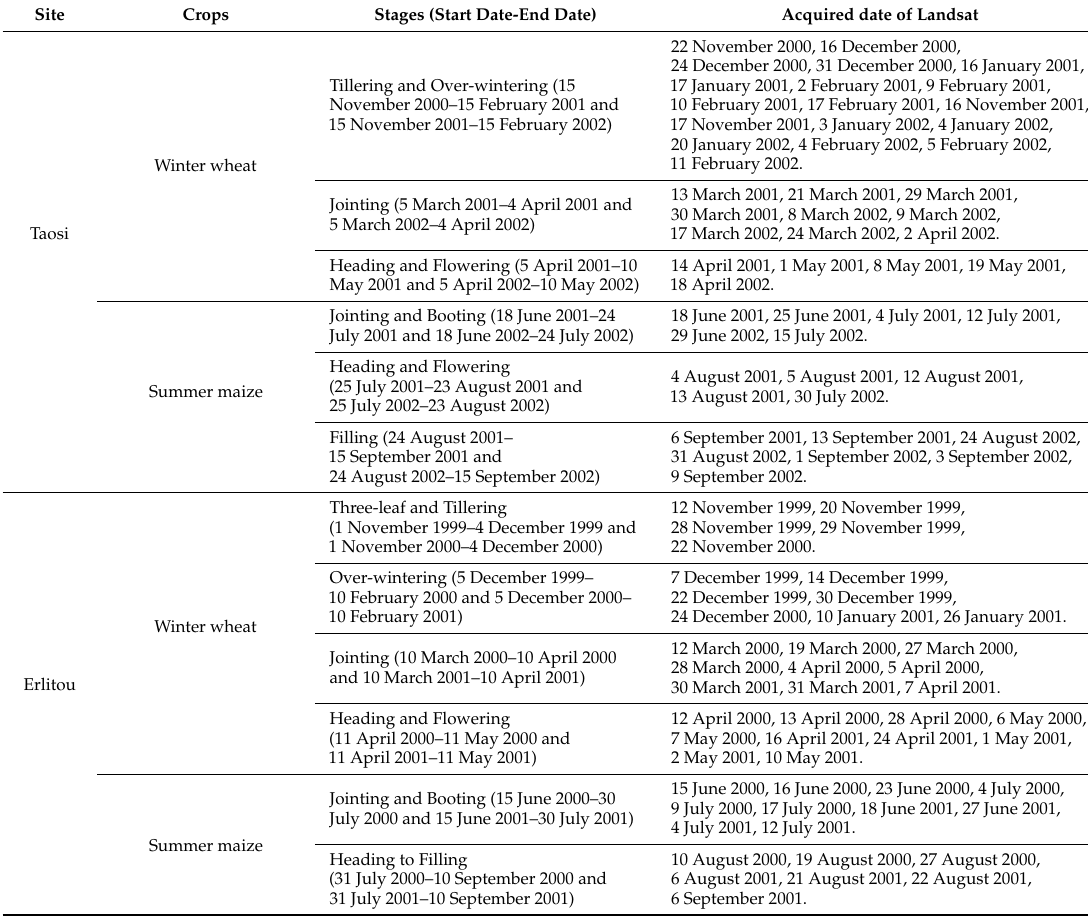
Table 1. Landsat data acquisition